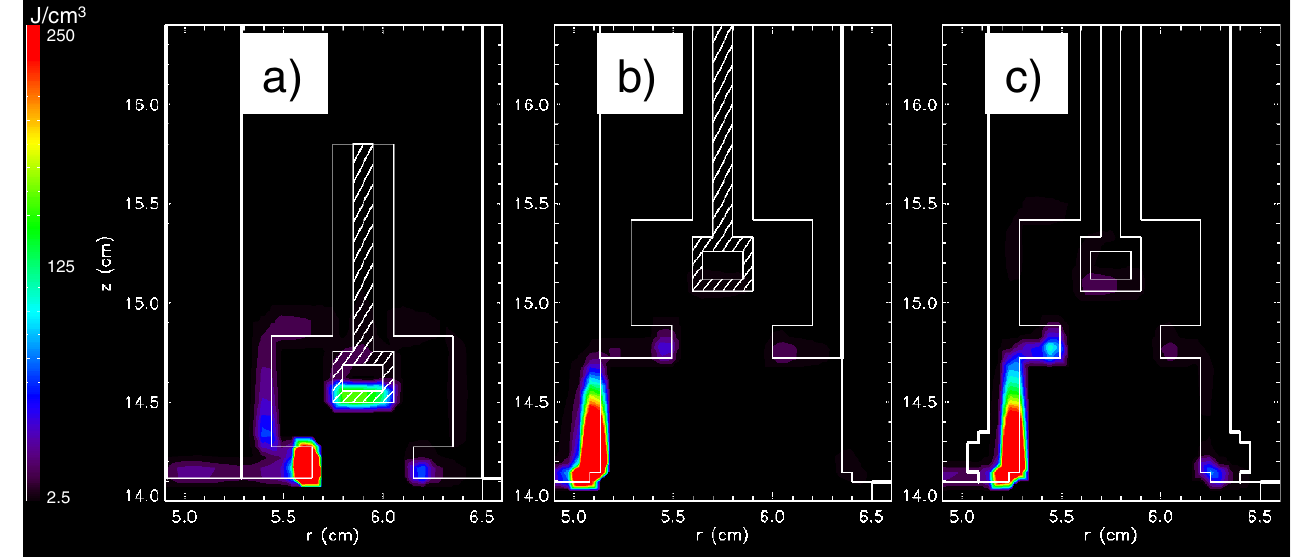
FIG. 6. (Color) Simulated electron energy deposition in the (cid:1) ¼ 0 plane after 45 ns for the three inner-MITL B -dot probe designs: (a) original, (b) best, and (c)